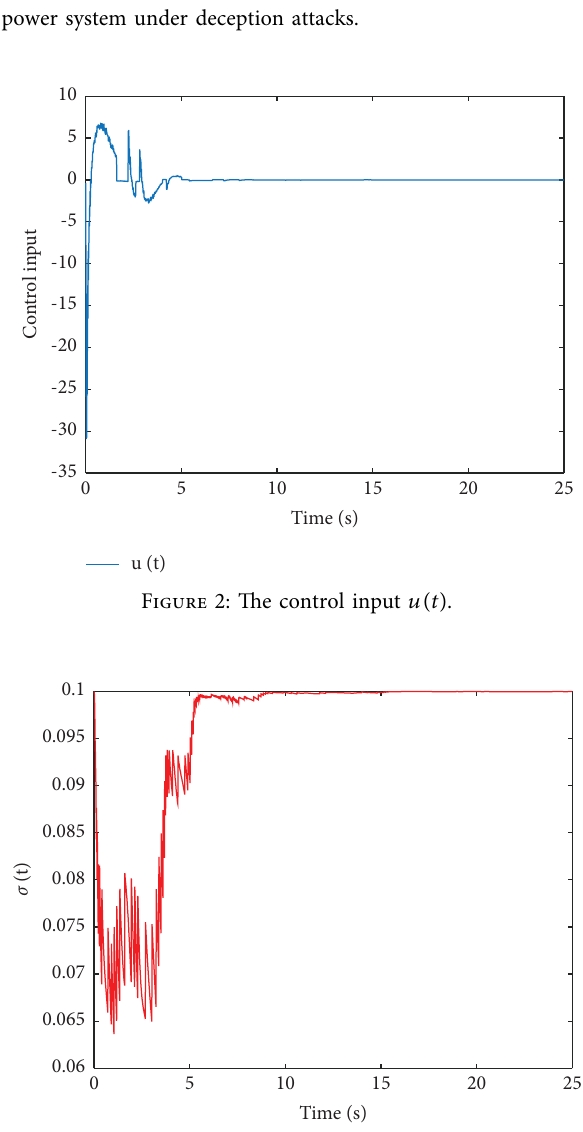
Figure 3: Te evolution of the adaptive parameter σ ( t )